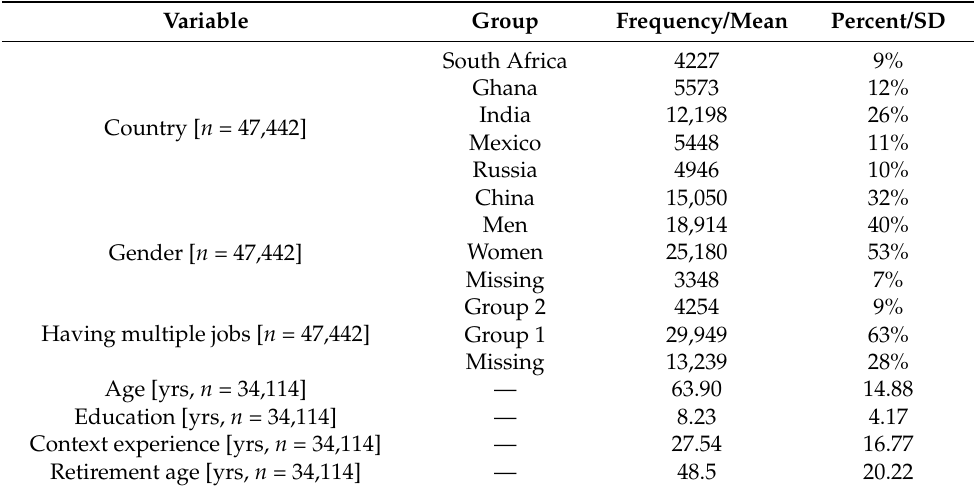
Table 1. Summary statistics on personal